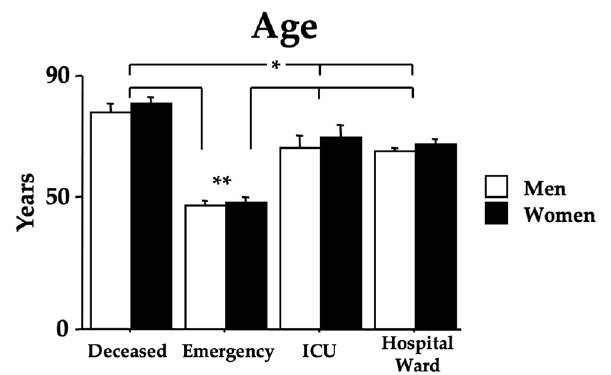
Figure 2. Age in years of the recruited individuals. The error bars indicate pooled standard error means (SEM) derived from the appropriate error mean square in the ANOVA. The asterisks (* p < 0.05; ** p < 0.01) indicate post hoc differences with the emergency group. In order to assess the recruited individuals’ lung function, we used the Horowitz Index for Lung Function (P/F Ratio) (Figure 3). In the absence of a sex effect (Figure 3 is presented without the sex parameter), the data clearly evidence a main effect of morbidity with low values that depend on the Omicron COVID-19 severity [F(3,440) = 28.20, p < 0.01]. Indeed, in the post hoc comparisons, the deceased group had the lowest values compared to the other groups (ps < 0.05); furthermore, the individuals in the ICU and hospital ward groups also had low values when compared to the individuals in the emergency group (ps < 0.05).